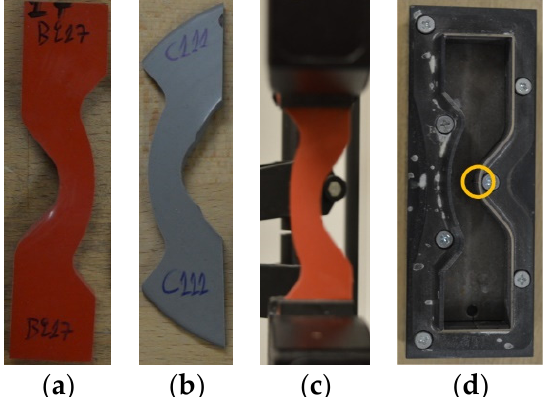
Figure 2. ( a ) Complete crescent test piece, ( b ) example of incomplete crescent test piece due to small size of composite insulator’s shed, ( c ) correct fixation on the tensile testing machine of an incomplete (at the edges) test piece, ( d ) the crescent cutting die used in this investigation and the metallic ledge (in orange circle), which is used to create the required, by the standard ISO 34-1 [13], nick on the test piece.